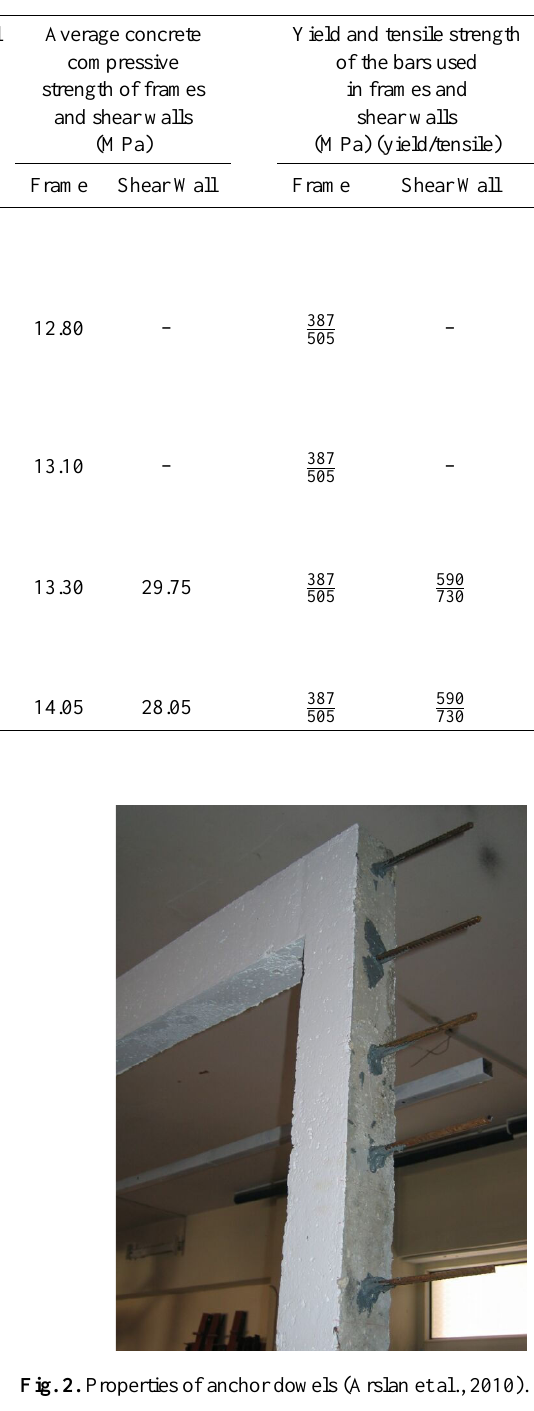
Table 1. Characteristics of the specimens in the 1st test program.